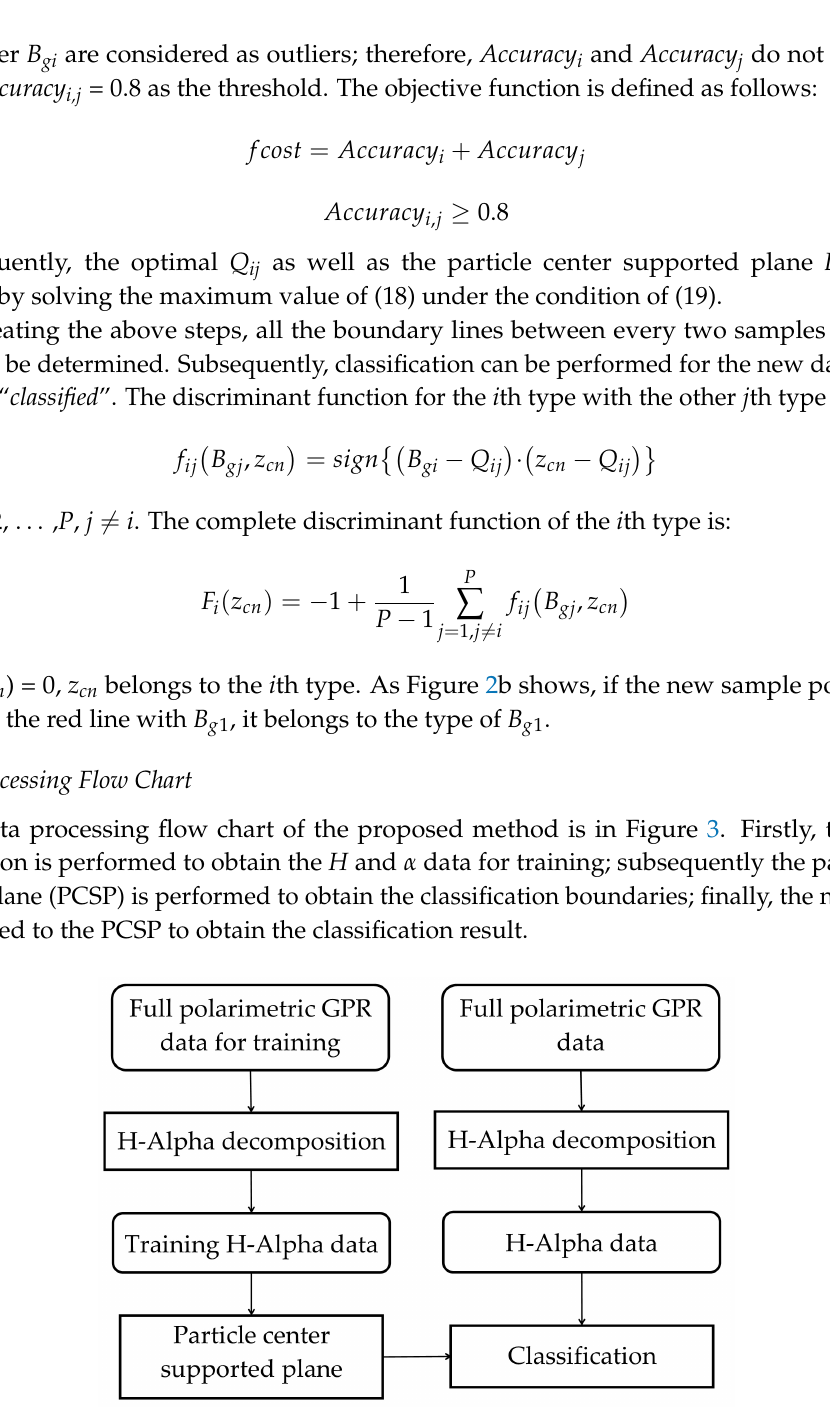
Figure 3. Data processing flow chart.